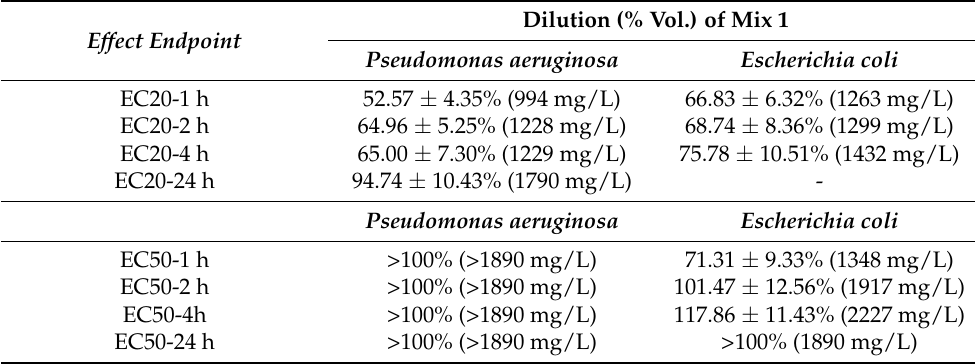
Table 2. EC20 and EC50 estimation for Mix